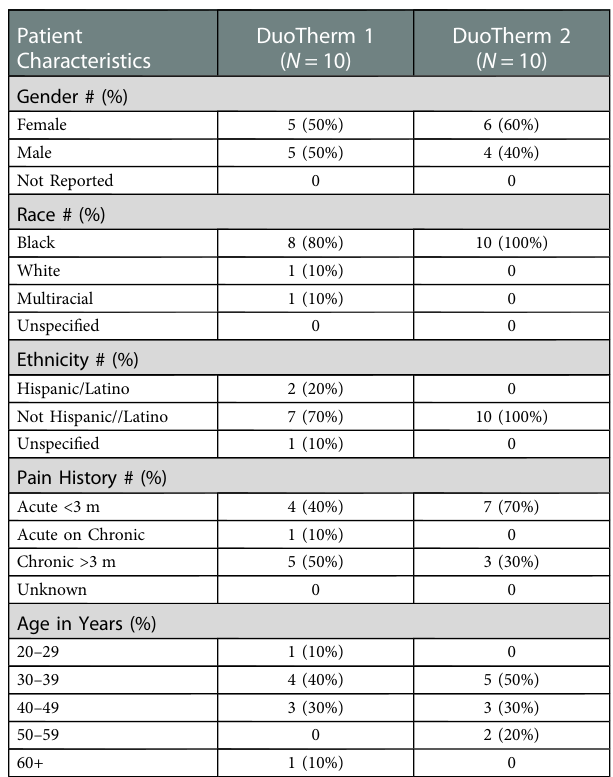
TABLE 1 Patient demographic